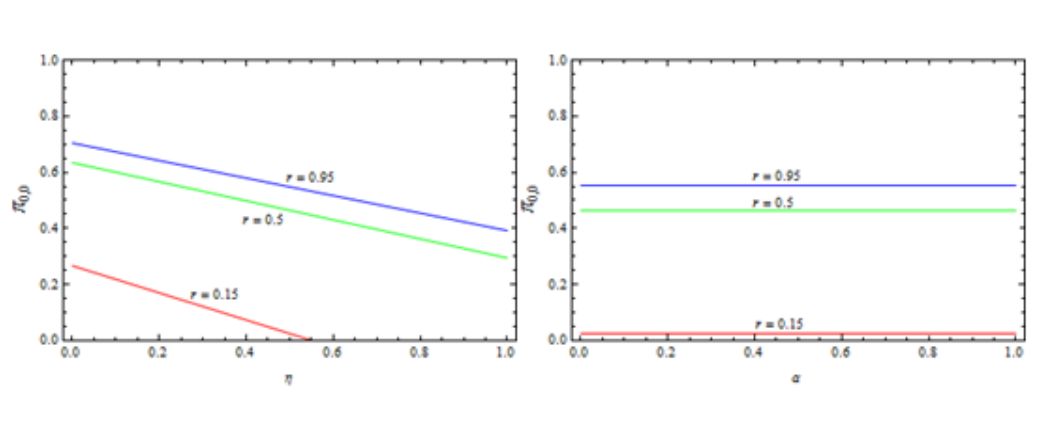
Figure 2. p 0,0 versus h for different r Figure 3. p 0,0 versus a for different